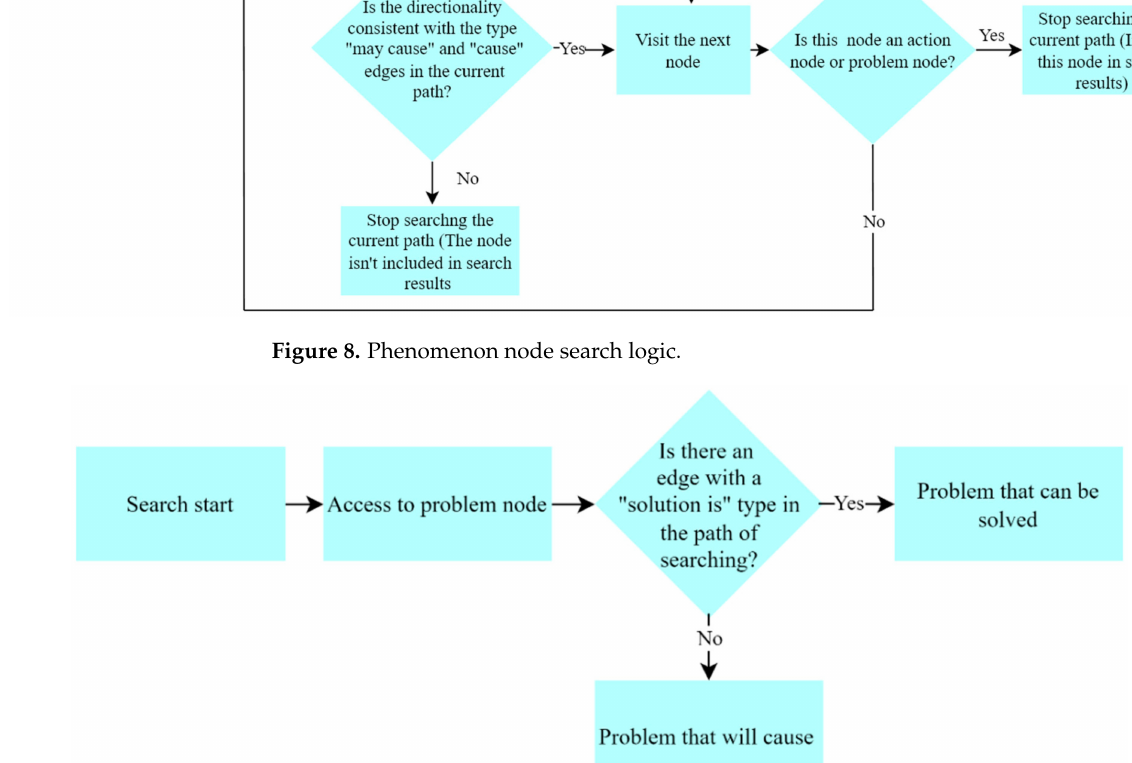
Figure 9. Schematic diagram of the problem node